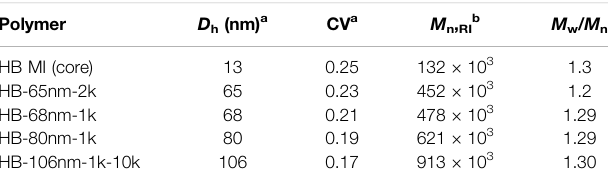
Table 1 . For the HB MI core, the apparent number-average molecular weight based on linear PMMA standards in SEC with DMF as mobile phase is M n (cid:1) 132,000, which is lower than its absolute value M n (cid:1) 328,000, determined by MALLS detector coupled in THF SEC system, suggesting a high degree of branching (DB) in the HB MI. Indeed, the DB was con fi rmed by 1 H NMR spectroscopy of the puri fi ed HB MI as DB (cid:1) 0.27 (i.e.